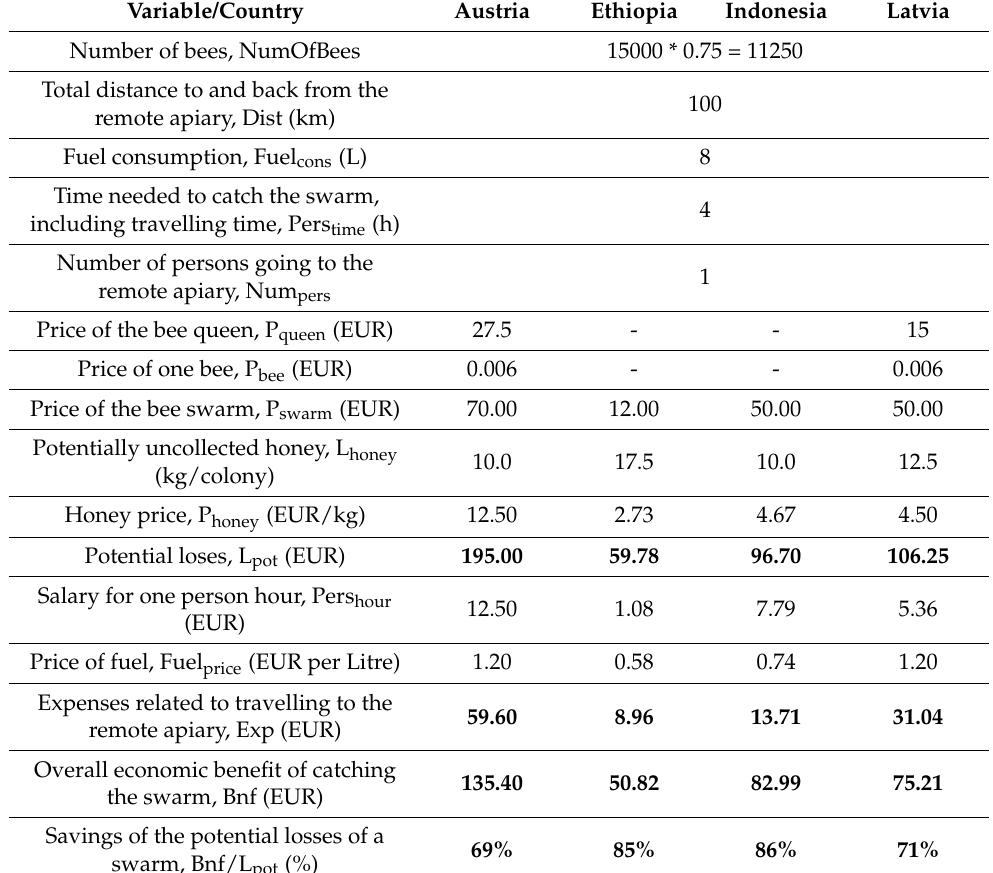
Table 1. Example calculation for the economic model including travelled distance for four countries.